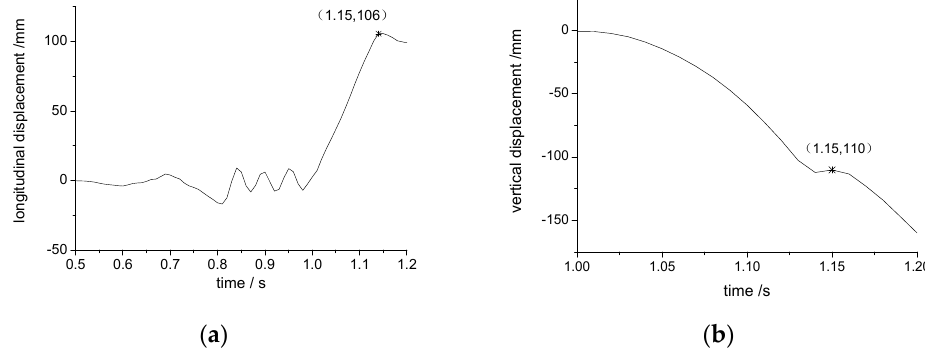
Figure 13. Displacement time history curve of the middle pier top: ( a ) longitudinal ( b ) vertical.